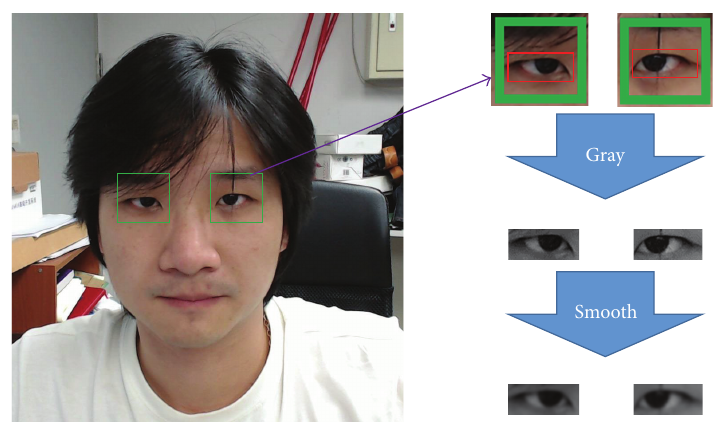
Figure 8: Illustration of extracting the eyeball regions in the detected eye regions.